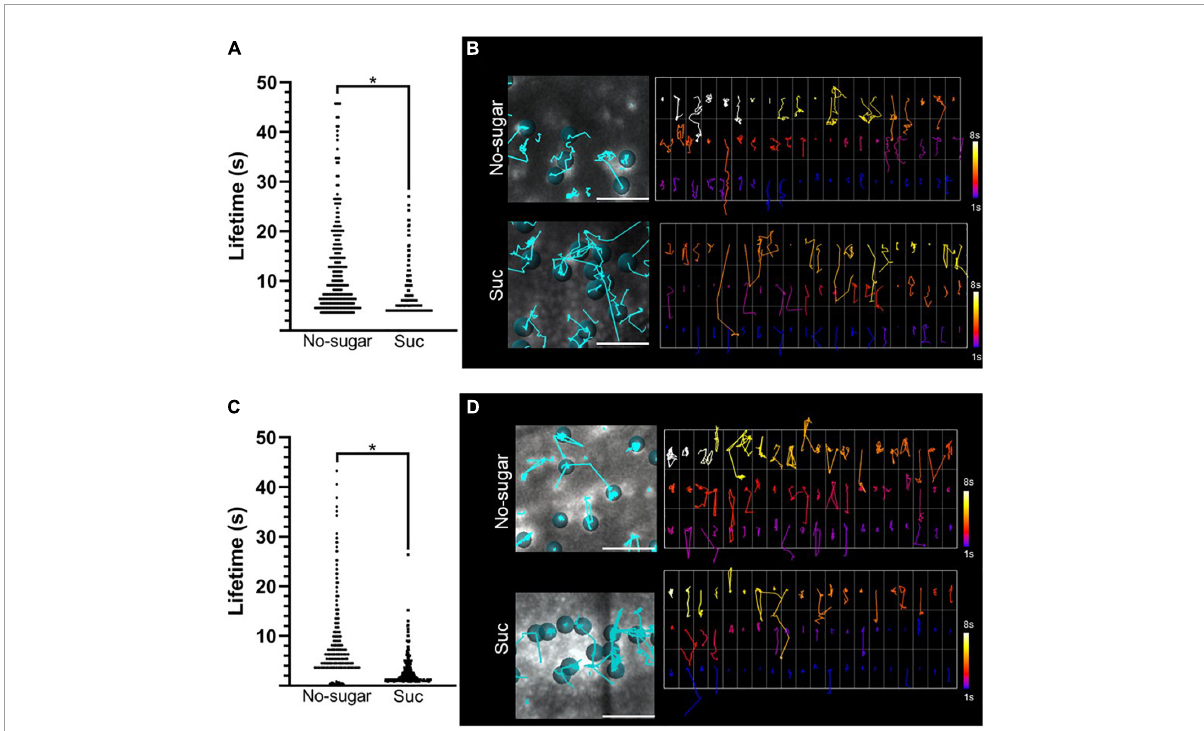
FIGURE4 Plasma membrane residence times of CLC2-GFP and AP2 µ 2-YFP are reduced by sucrose. CLC2-GFP and AP2 µ 2-YFP transgenic Arabidopsis seeds were sown on sugar-free (No-sugar) or sucrose-supplemented (60 mM; Suc) solid medium. The dynamics of CLC2-GFP and AP2 µ 2-YFP at the plasma membrane were analyzed by TIRF microscopy. (A–C) Plasma membrane lifetimes of CLC2-GFP (A) and AP2 µ 2-YFP (C) foci were evaluated. Total data distribution by condition is shown ( n ≥ 5 seedlings). Student’s t -test; * p < 0.05. (B–D) Tracking of CLC2-GFP (B) and AP2 µ 2-YFP (D) foci on TIRF images is shown (left panels). Cyan lines show trajectory of representative foci indicated by dots. The plasma membrane residence time for each tracked foci is shown as a code color scale (right panels). Code color scale is